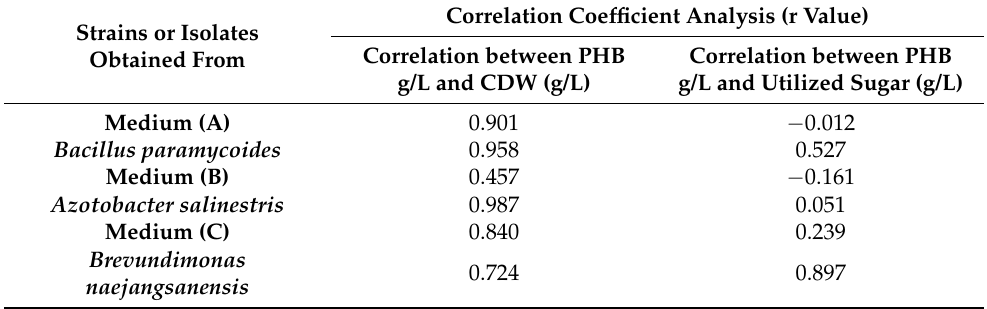
Table 3. The correlation analysis between PHB, dry cell weight and utilized